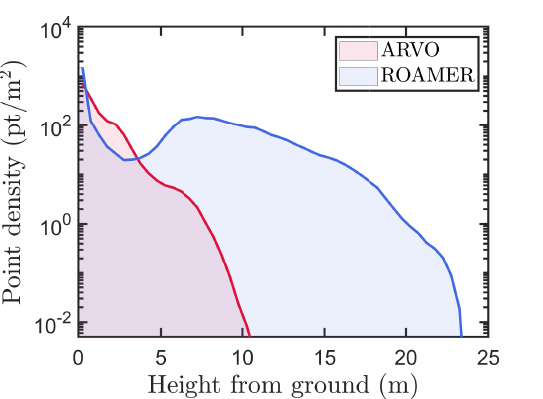
Figure 11. Average point density for height intervals with a width of ∆ z = 0.5 m as a function of the height from the ground level. The red (blue) curve denotes the point density within the point cloud data collected using the ARVO (ROAMER) system. Note the logarithmic scale on the y